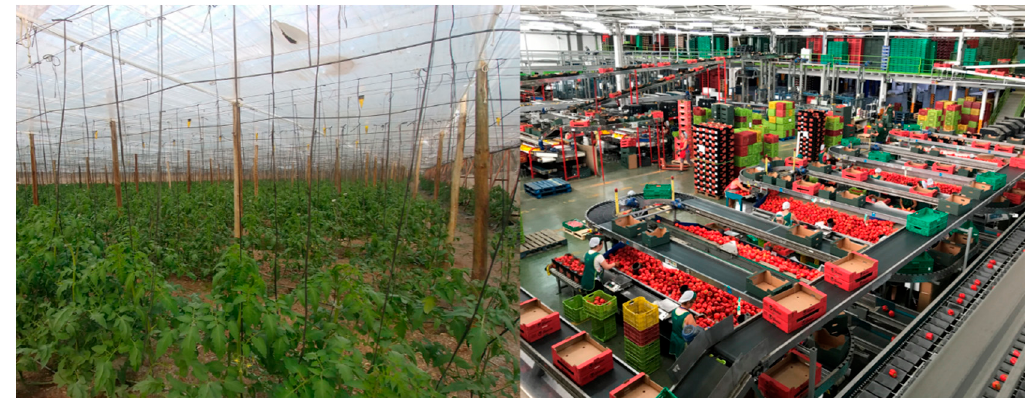
Figure 3. A greenhouse and the handling area of a distributing company.